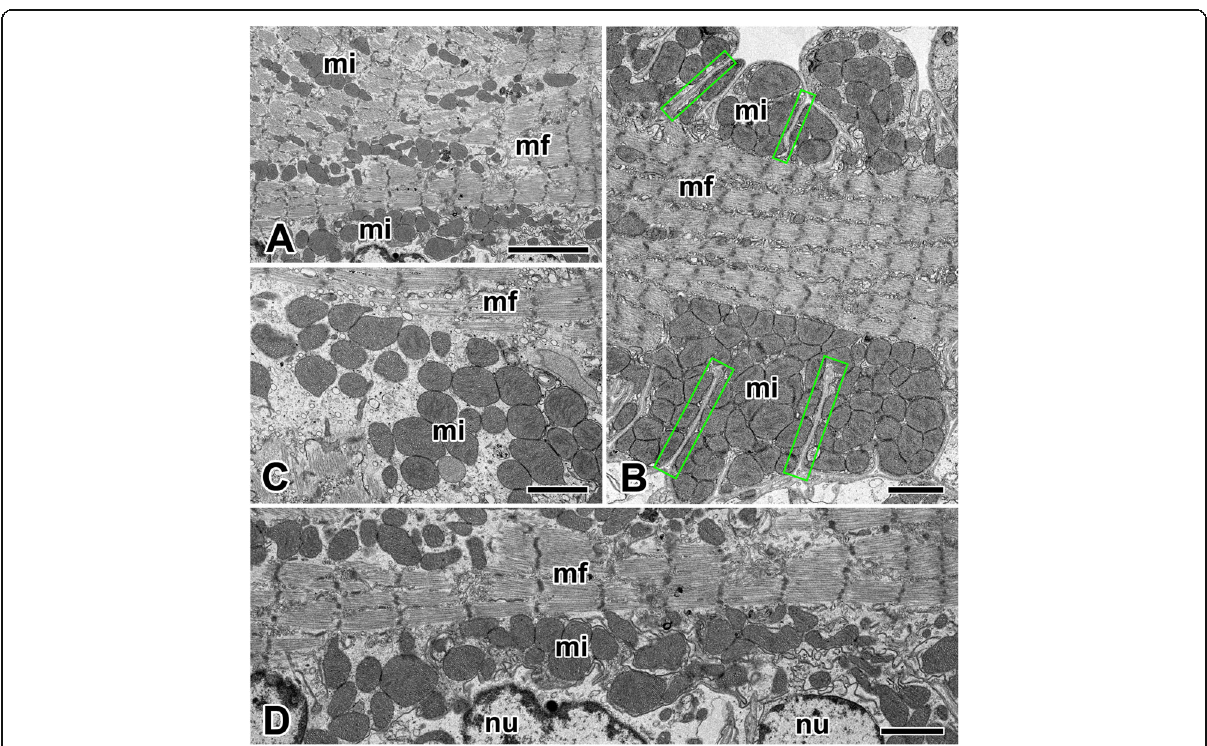
Fig. 3 Electron micrographs of the cytoplasmic mitochondria in the cardiac muscle cells in N. clavata . a : Cardiac muscle cells have a lot of myofibrils (mf) and mitochondria (mi) in the cytoplasm. b : Mitochondria are located in the scalloped edge of the sarcolemma (rectangles) surrounding the myofibrils (mf). c : Oval or elliptical shaped mitochondria contains well developed cristae that provide an increase area of surface. d : Bundles of myofibrils and numerous mitochondria are distributed along the long axis of the muscle fiber. cd: intercalated disc, nu: nucleus. Scale bars indicate 5 μ m ( a ) and 2 μ m ( b-d ),